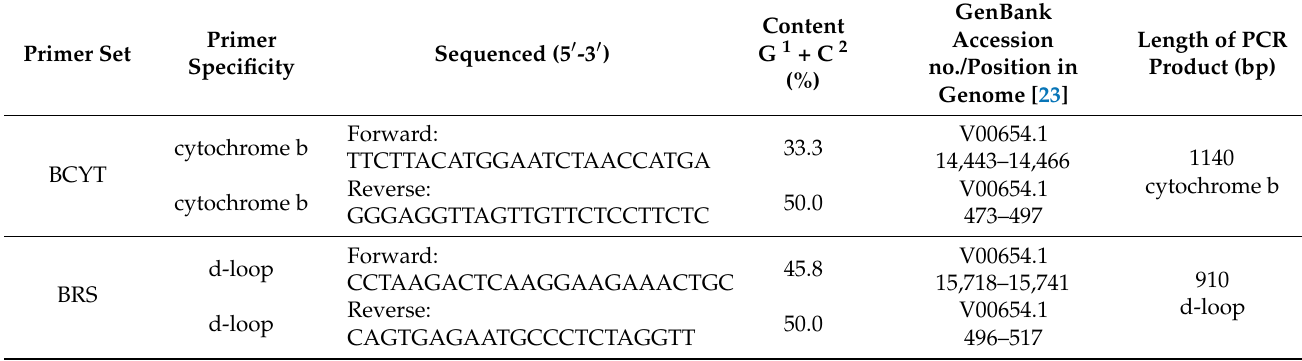
Table 2. Characteristics of the primer pairs used to amplify the gene sequences by